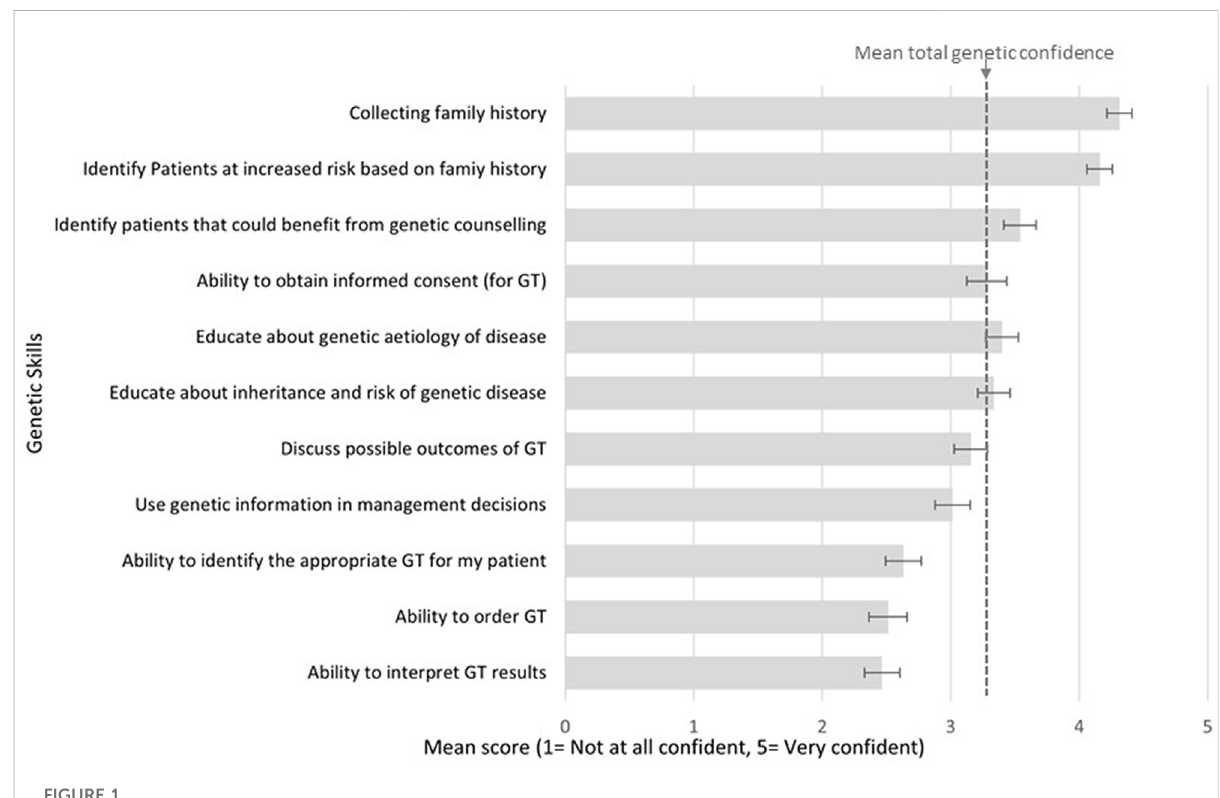
FIGURE 1 Respondents reported con fi dence in basic genetic